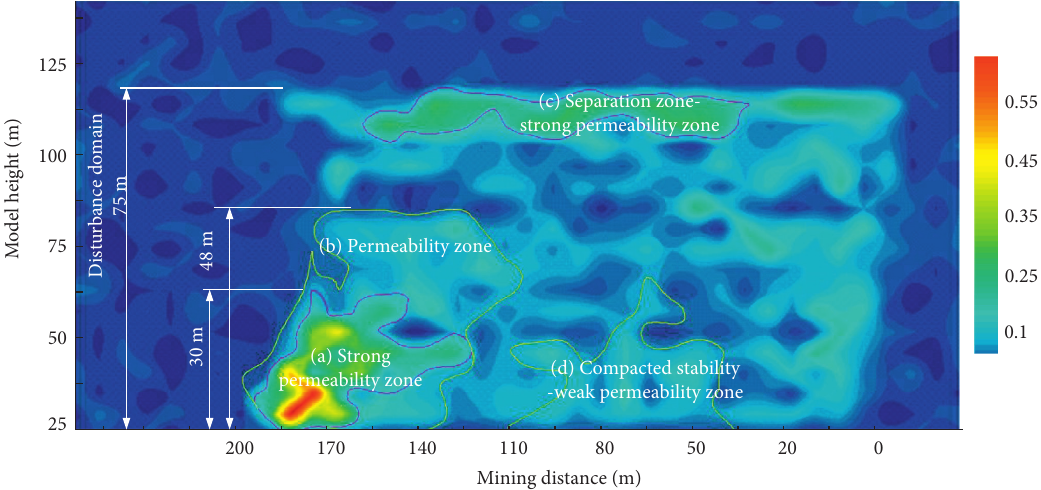
Figure 18: Permeability zoning in goaf when excavated to 190m of Scheme 2.